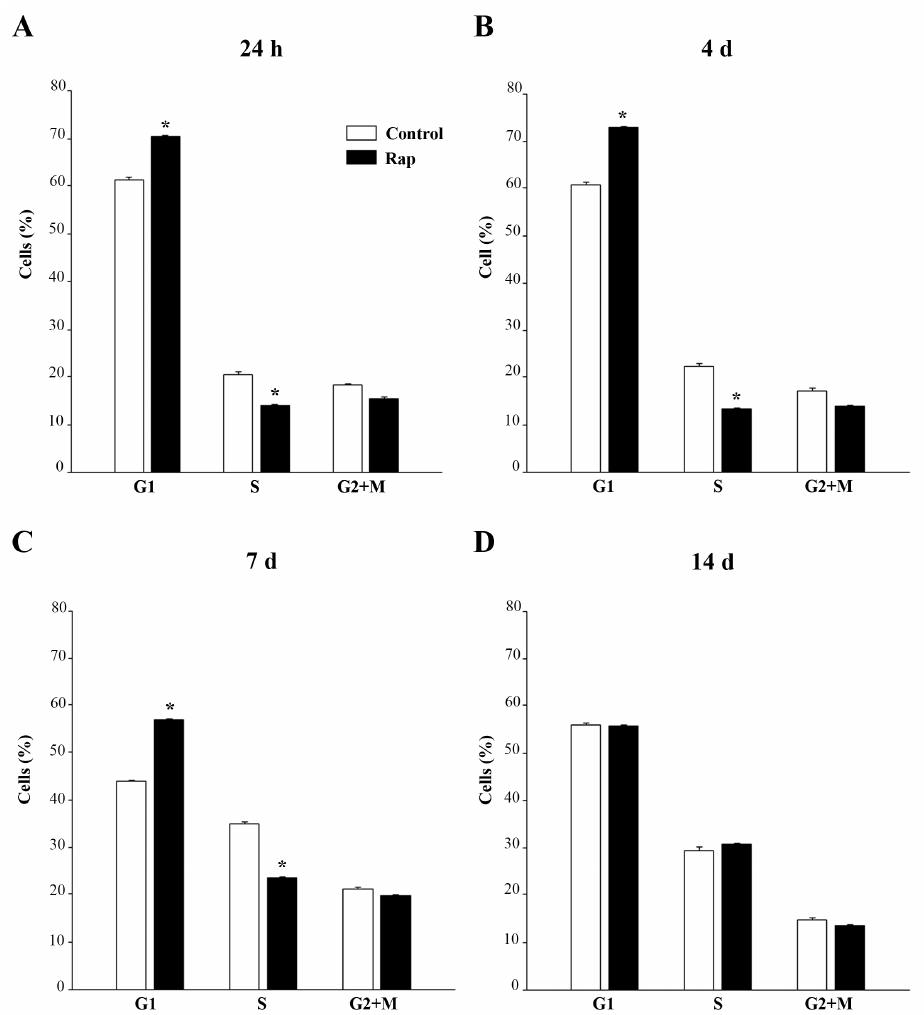
Figure 4. Rapamycin induces a long lasting G1 arrest. U87MG cells were treated with 10 nM rapamycin and the cell cycle was analysed after 24 h ( A ) and at 4 days, 7 days, 14 days after rapamycin removal ( B – D , respectively). Values are given as the mean ± SEM from three independent experiments. * p < 0.05 compared with controls.